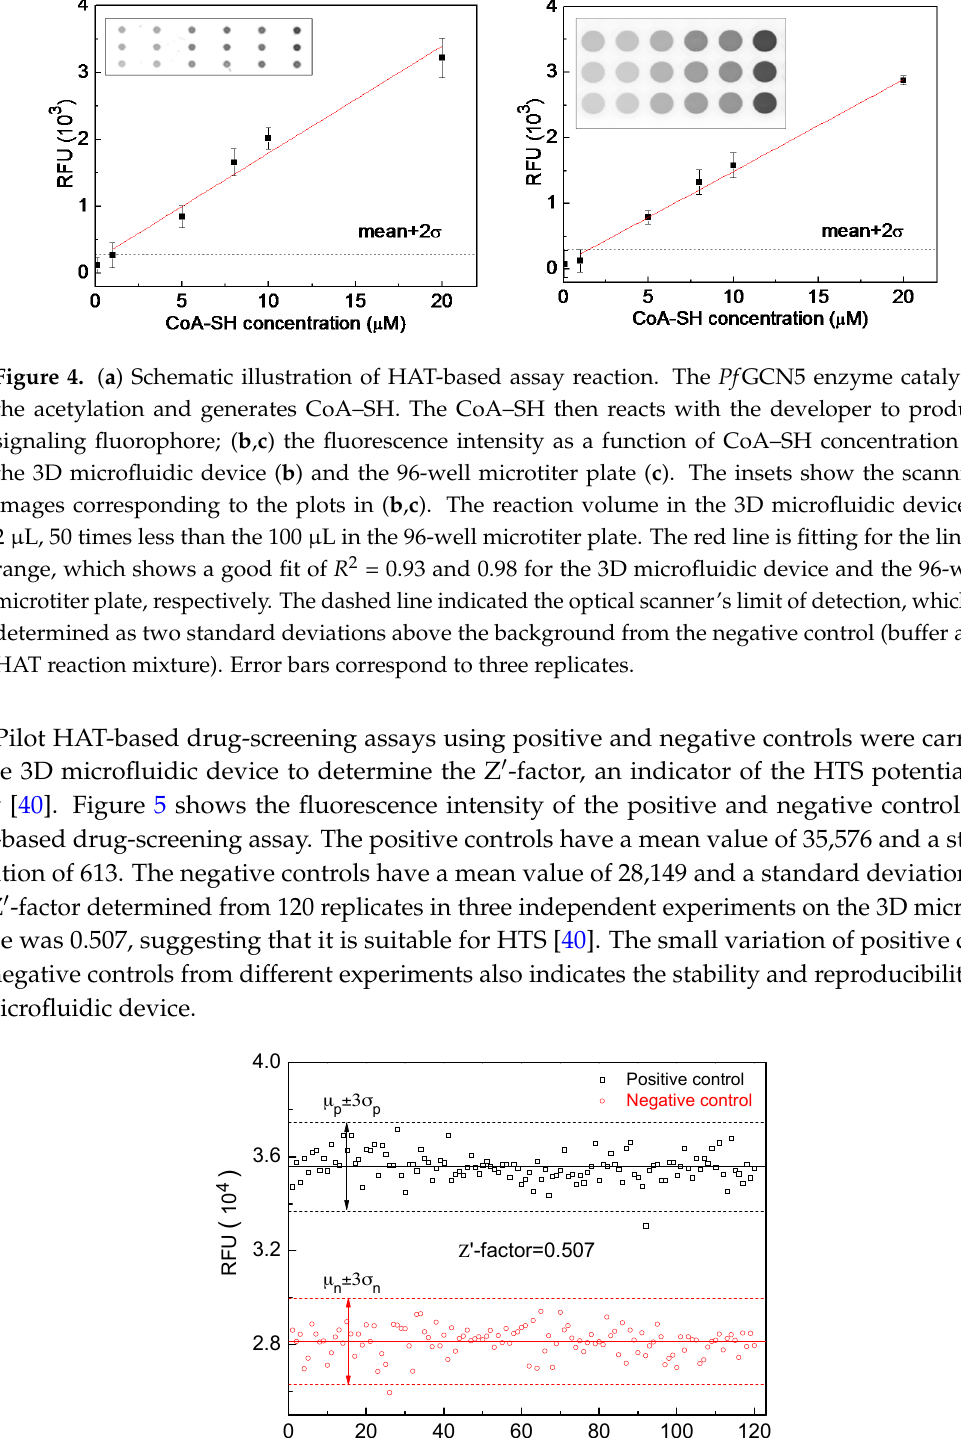
Figure 5. Z ′ -factor determination of the HAT-based drug-screening assay on the 3D microfluidic device. The solid horizontal lines show the mean values of the positive control and negative control. Black and red dash lines display 3 standard deviations ( σ ) from the mean value of positive control and negative control data set. The Z ′ -factor is determined to be 0.507 according to Z ′ = 1 − ( 3 σ p + 3 σ n ) / | µ p − µ n | . A Z ′ -factor in the range between 0.5 and 1 indicates that the assay is suitable for HTS.